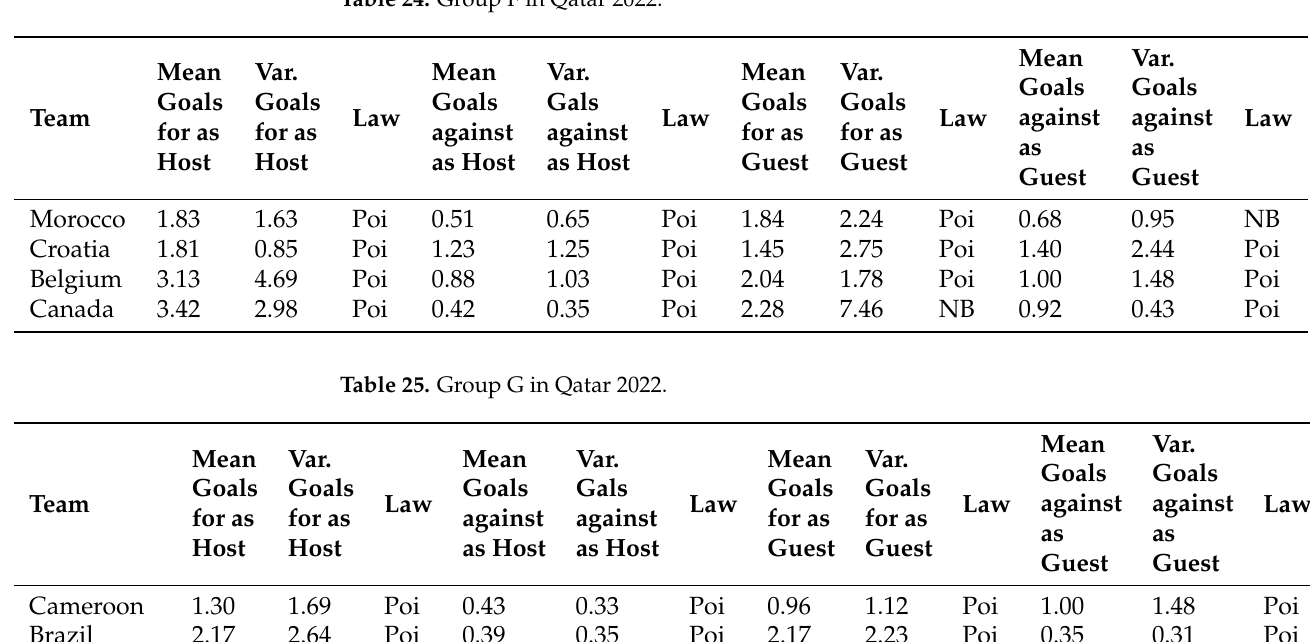
Table 24. Group F in Qatar 2022.